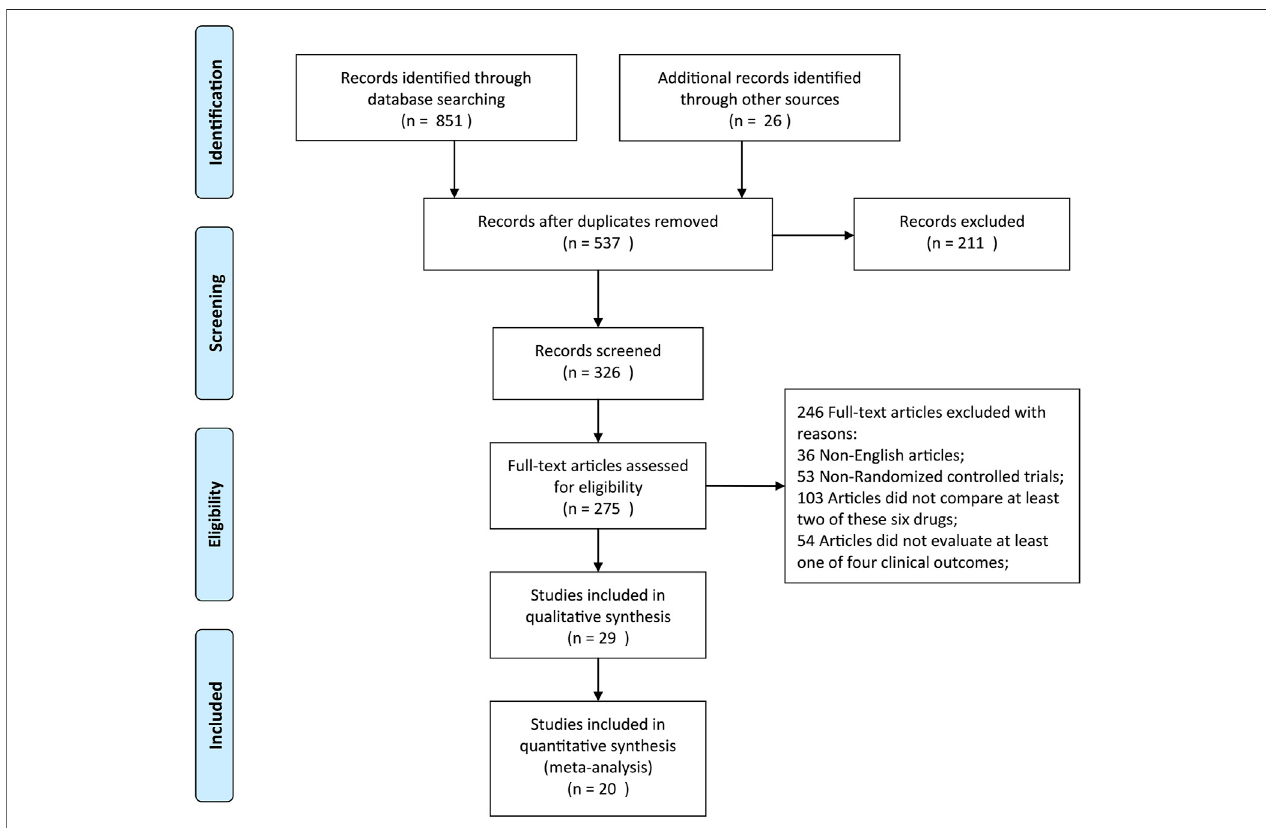
FIGURE 1 | Flow diagram of the literature selection